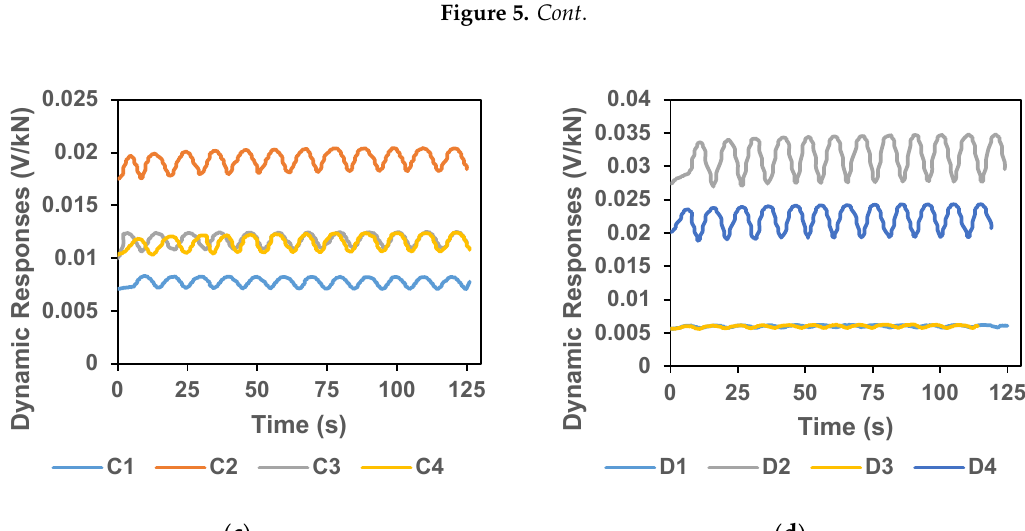
Figure 5. Cont . Sensors 2020 , 20 , x FOR PEER REVIEW